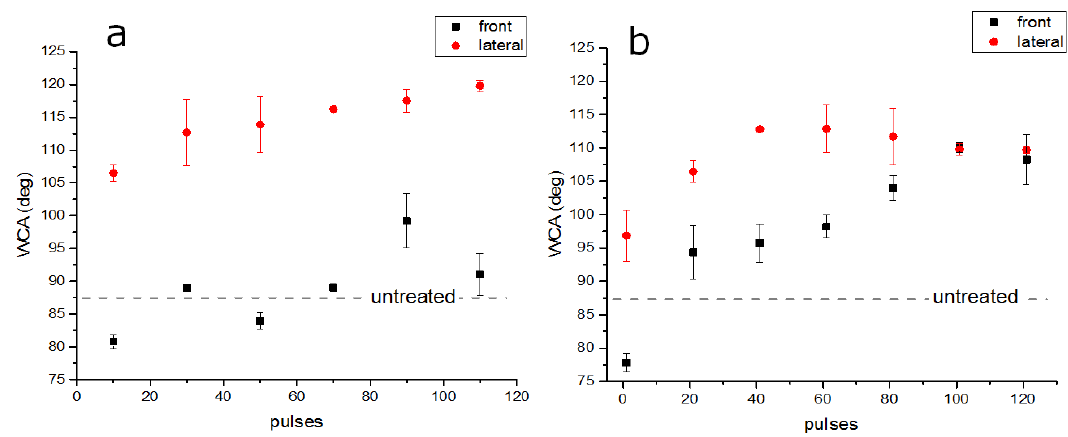
Figure 4. Water contact angle response measured in orthogonal directions for the different pulse-overlap conditions, for anisotropic line-like on pillars structures ( a ) and isotropic pillars on pillars structures ( b ) [30].